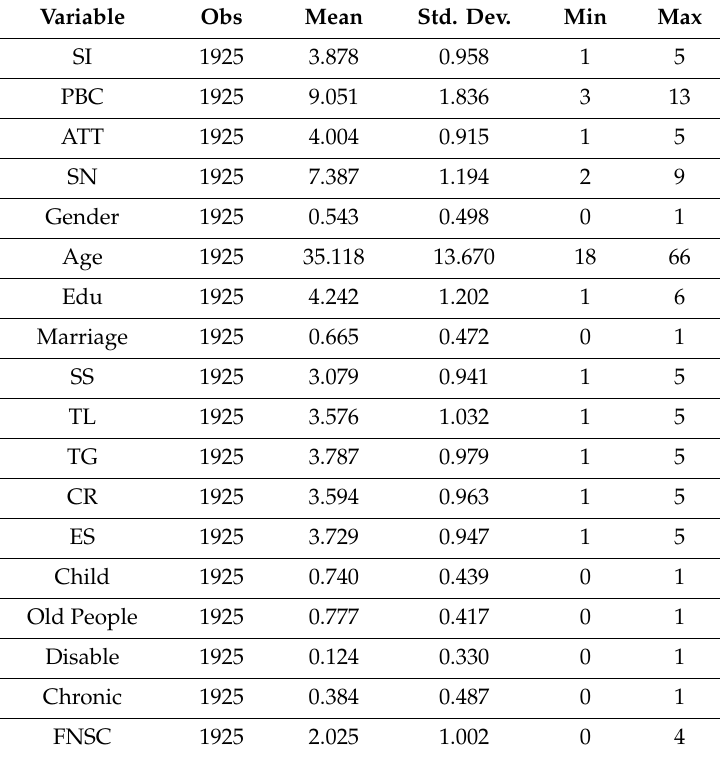
Table 2. Descriptive statistics of the variables.